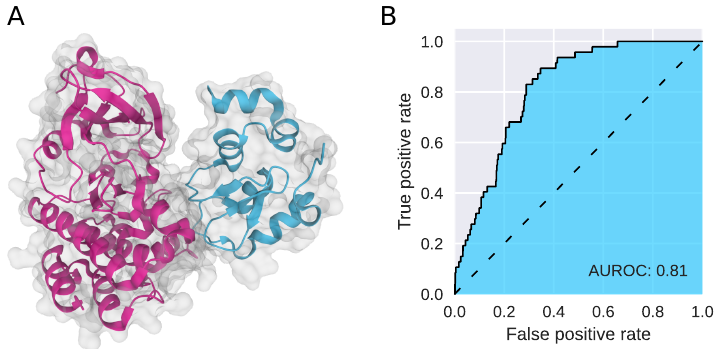
Figure 3. Example evaluation on ternary complex data. ( A ) PPIs of proteins involved in the ternary complex composed by BTK, cIAP ubiquitin ligase and compound 17 (PDB ID: 6W7O). ( B ) Corre- sponding AUROC curve. See Appendix B for predictions on additional ternary complex